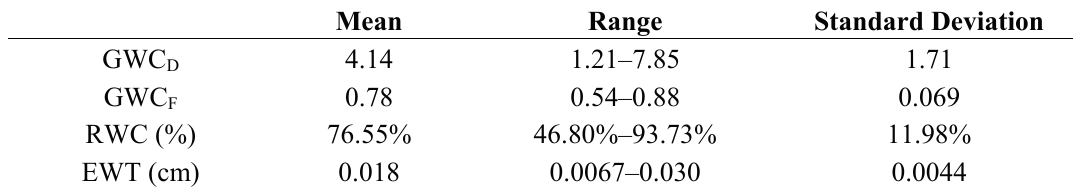
Table 3. Summary statistics for water-related properties at leaf level.